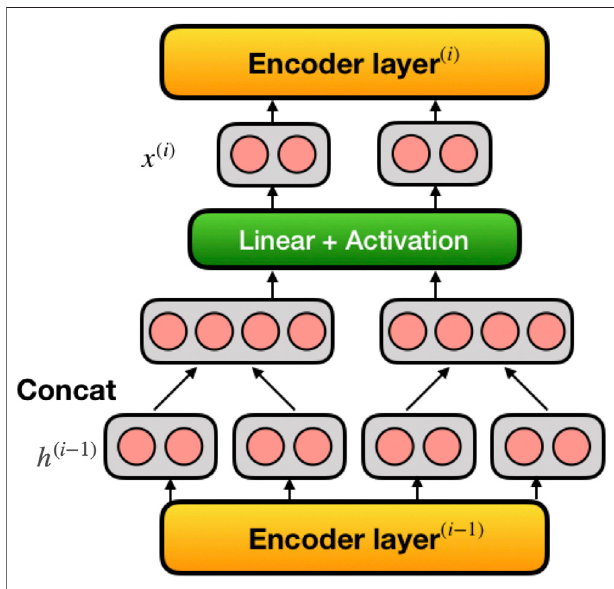
FIGURE 2 | Visualization of pyramid encoder in multilayer seq2seq models. Pyramid encoder reduces length of input sequence by half in every encoding layer. h ( i − 1 ) denotes output of ( i − 1 ) th encoder layer and x ( i ) denotes the input of i th encoder